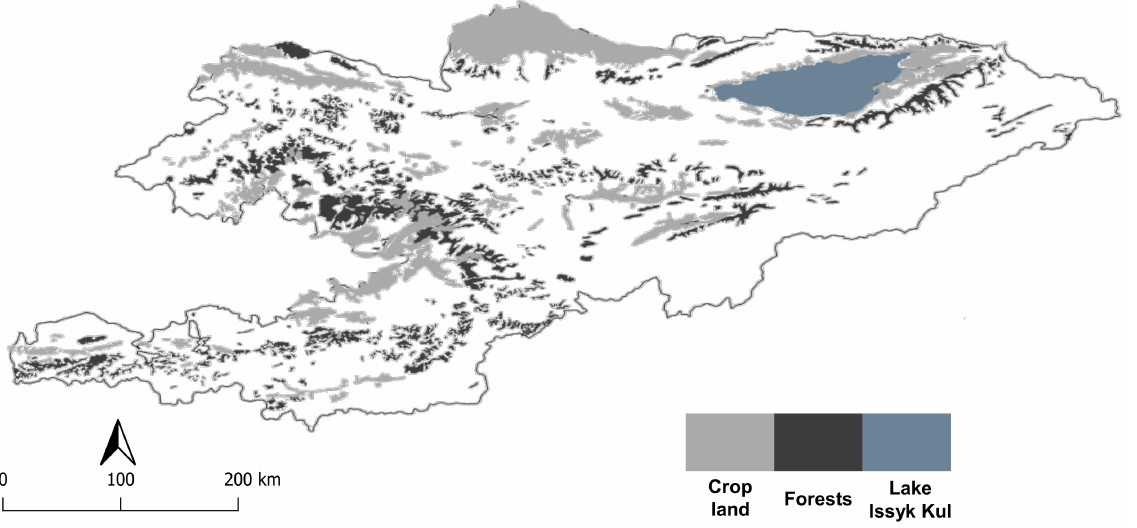
Figure 5. Cropland and forest areas in Kyrgyzstan (based on